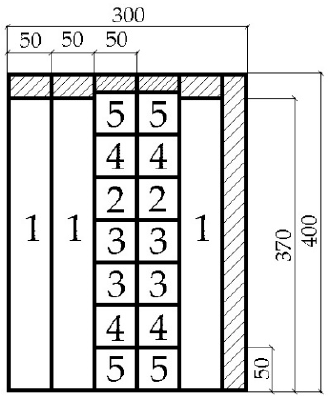
Figure 2. Cutting scheme for laboratory-manufactured PBs: 1—samples for testing modulus of rupture (MOR) and modulus of elasticity (MOE) by 3-point bending test [48], 2—samples for testing thickness swelling (TS) and water absorption (WA) after 2 and 24 h [46,47], 3—samples for testing internal bond (IB) [49] and density [44], 4—samples for testing biological resistance to the fungus Coniophora puteana [50], and 5—spare samples.